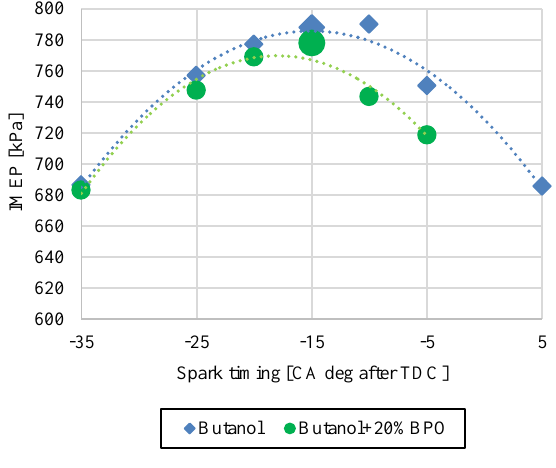
Fig. 12. IMEP for butanol and Butanol + 20% BPO